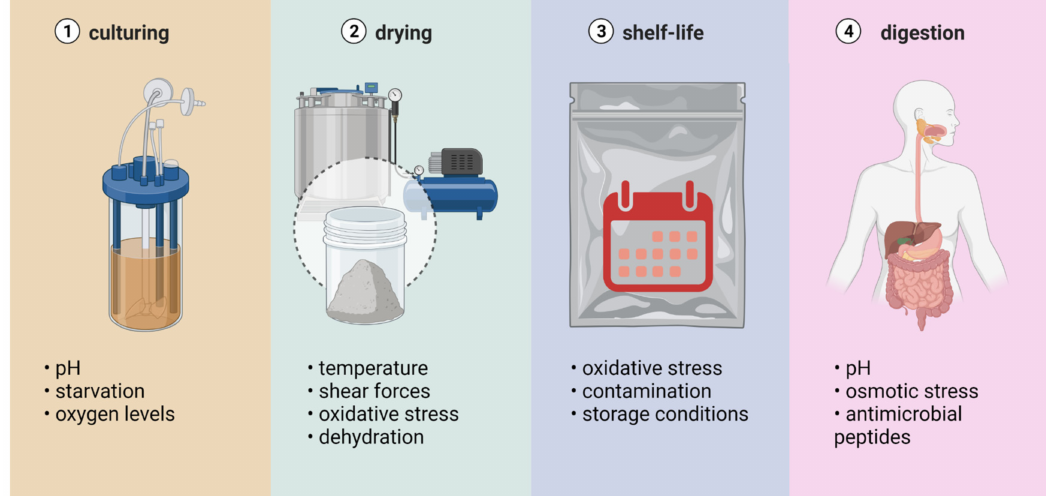
Figure 3. Stress factors affecting probiotics during different stages of their preparation and adminis- tration. Created with Biorender.com (accessed on 27 July